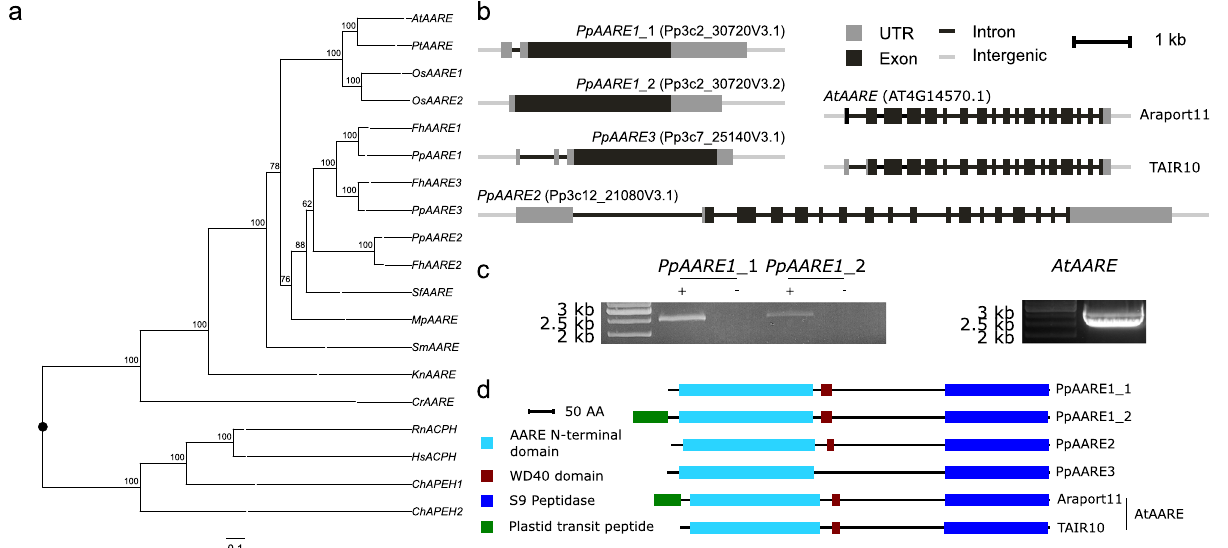
Fig. 1 Phylogenetic tree for AARE isoforms from selected organisms, gene structures, and proteins domains of P. patens and A. thaliana AARE isoforms. a Maximum likelihood tree based on an alignment of multiple AARE coding sequences. Duplication events in several species appear to be lineage-speci fi c. Node values re fl ect percentage con fi dence values based on 1000 bootstrap replicates. Species abbreviations: At: Arabidopsis thaliana ; Pt: Populus trichocarpa ; Os: Oryza sativa ; Pp: Physcomitrium patens ; Fh: Funaria hygrometrica ; Sf: Sphagnum fallax ; Mp: Marchantia polymorpha ; Sm: Selaginella moellendorf fi i ; Kn: Klebsormidium nitens ; Cr: Chlamydomonas reinhardtii ; Rn: Rattus norvegicus ; Hs: Homo sapiens ; Ch: Chionodraco hamatus . b Gene structure of PpAARE1-3 and AtAARE . For PpAARE1 two splice variants exist. For AtAARE two different 5 ’ UTR de fi nitions are present (upper: Araport11 62 ; lower: TAIR10 53 ). c Left: Both splice variants of PpAARE1 were ampli fi ed from complementary DNA (cDNA; + : with cDNA template; -: without reverse transcriptase). Expected amplicon size: PpAARE1_1 : 2512 bp; PpAARE1_2 : 2596 bp. Primers were designed to be speci fi c for the splice variants (Supplementary Data S1). Right: the longer open reading frame of AtAARE was ampli fi ed from cDNA. Expected amplicon size: 2457 bp (Supplementary Data S3). d Protein structures showing PFAM-domains for PpAARE1-3 and AtAARE. All isoforms contain an AARE N-terminal domain (PF19283) and a catalytic Peptidase S9 domain (PF00326). PpAARE1, PpAARE2, and AtAARE additionally contain a WD40 domain (PF07676). The long splice variant of PpAARE1 and the longer open reading frame of AtAARE encode a predicted N-terminal plastid transit peptide (cTP). AA amino acid. Cleavable N -terminal sequences were predicted by TargetP2.0 63